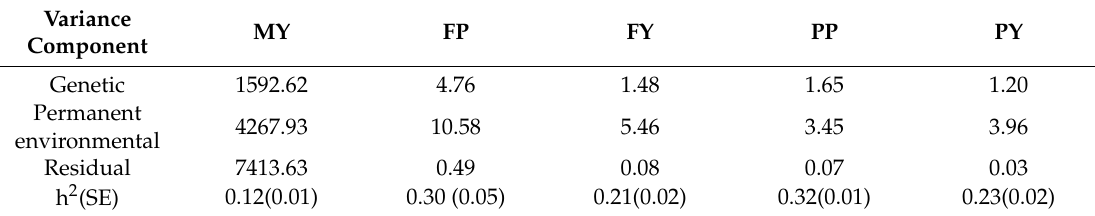
Table 1. Variance components and heritability of milk traits